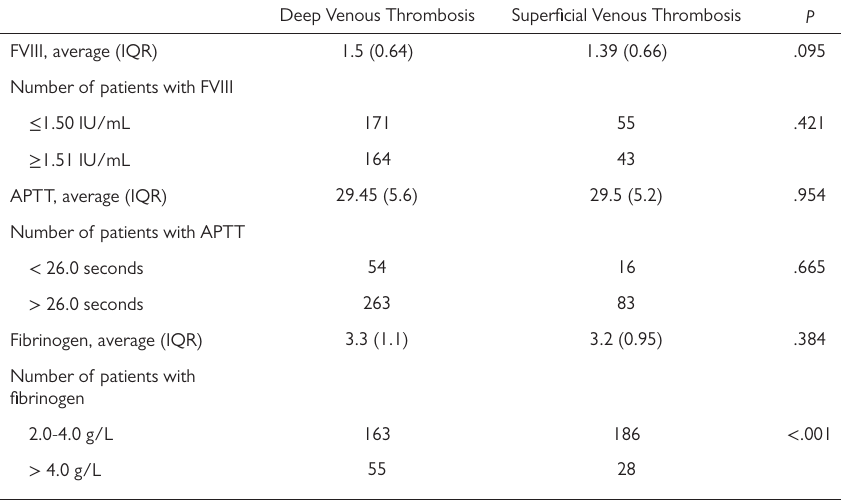
higher number of those with DVT had elevated fibrinogen level, P < .001 (Table 2).